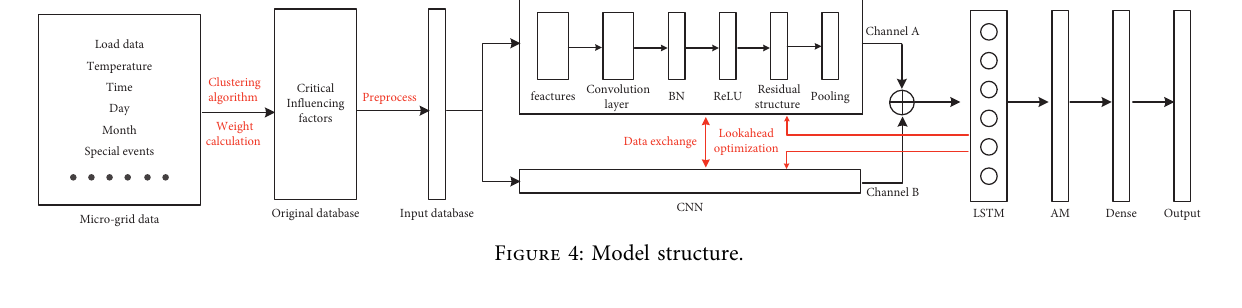
Figure 4: Model structure.